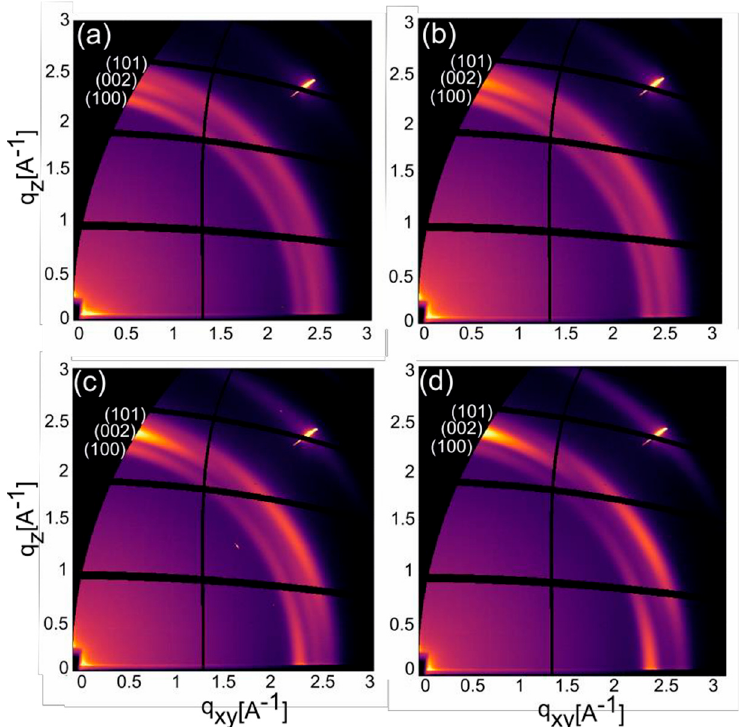
Figure 2. GIXD-maps of PE-ALD ZnO thin films deposited at substrate temperature of ( a ) 50 °C, ( b ) 100 °C, ( c ) 150 °C, and ( d ) 200 °C. The diffraction rings are labeled with their respective hkl values on the left ((100), (002), and